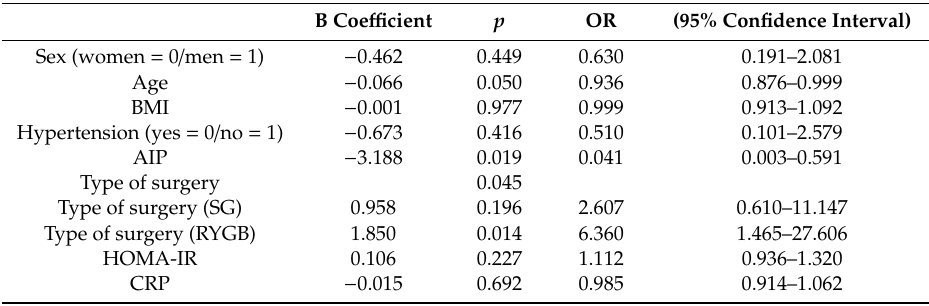
Table 3. Variables associated with a %EWL ≥ 50% (%EWL < 50% (0) and %EWL ≥ 50% (1)) obtained from a logistic regression